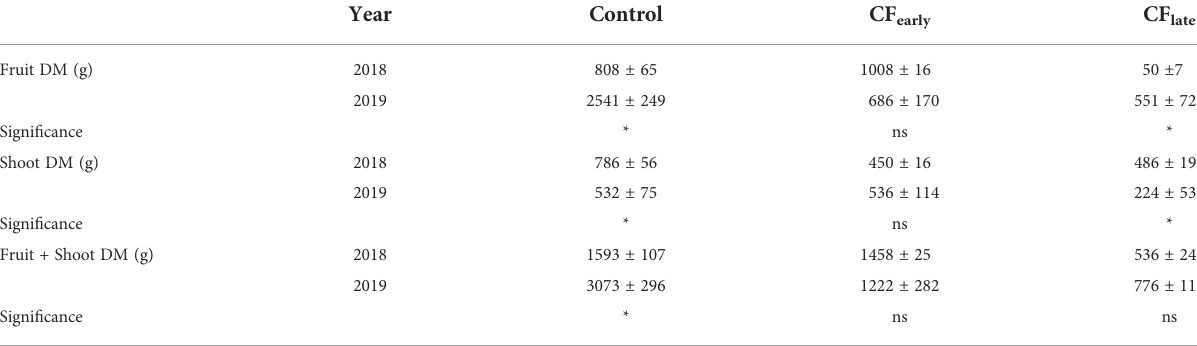
TABLE 3 Effects of crop forcing on dry matter partitioned to fruit and shoots between years 2018 and 2019.